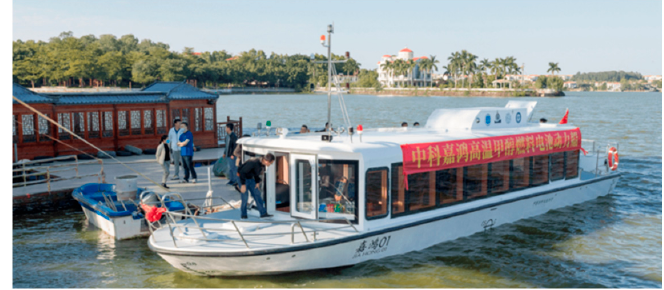
Figure 33. The demonstration cruise ship “Jia Hong 01” [157].